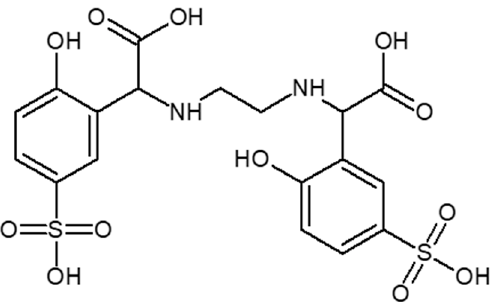
Figure 3. Structure of ethylenediamine- N,N ′ -di[(2-hydroxy-5-sulfophenyl) acetic acid] (EDDHSA).